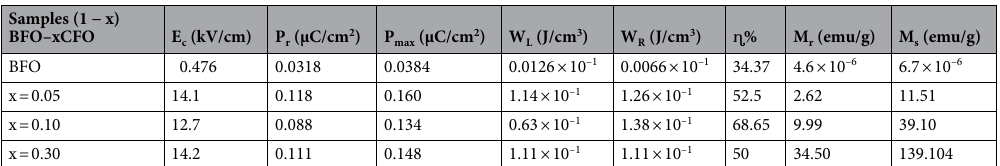
Table 2. Calculated recoverable energy density (W R ), energy loss density (W L ), efficiency of energy storage density ( ƞ ), coercive field (E c ), maximum polarization (P max ), remnant polarization (P r ), remnant magnetization (M r ), saturation magnetization (M s ) for [(1 − x) BFO–xCFO (x = 0.00, 0.05, 0.10 and 0.30)] ceramic samples.